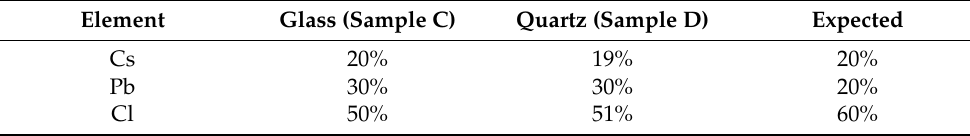
Table 2. XPS experimental atomic ratio and expected values for samples C and D. Element